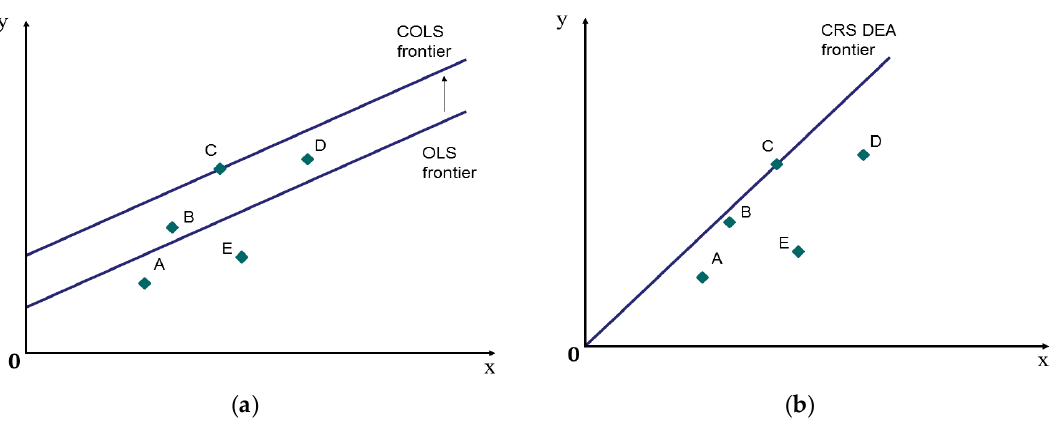
Figure 3. Similarity between COLS and CRS DEA. ( a ) COLS frontier; ( b ) DEA frontier. Source: Adapt from Greene (2008, Figure 2.3, p. 106).